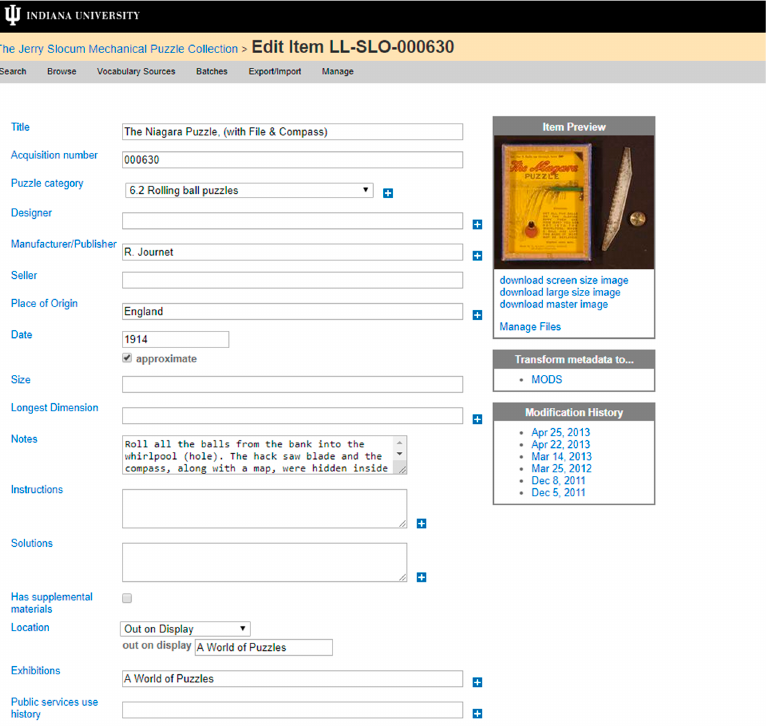
Figure 2. Screen shot of Image Collections Online service. Publications 2019 , 7 , x FOR PEER REVIEW